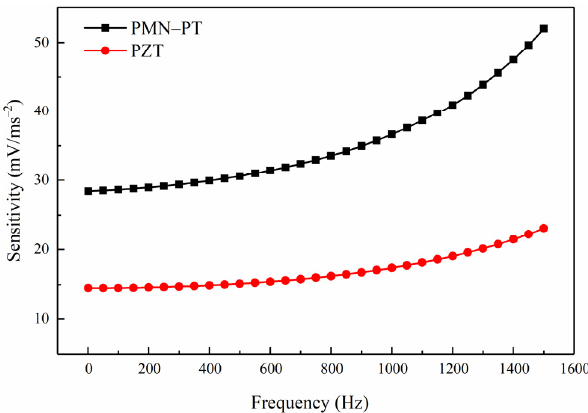
Figure 7. The sensitivity of the models based on PMN-PT and PZT.